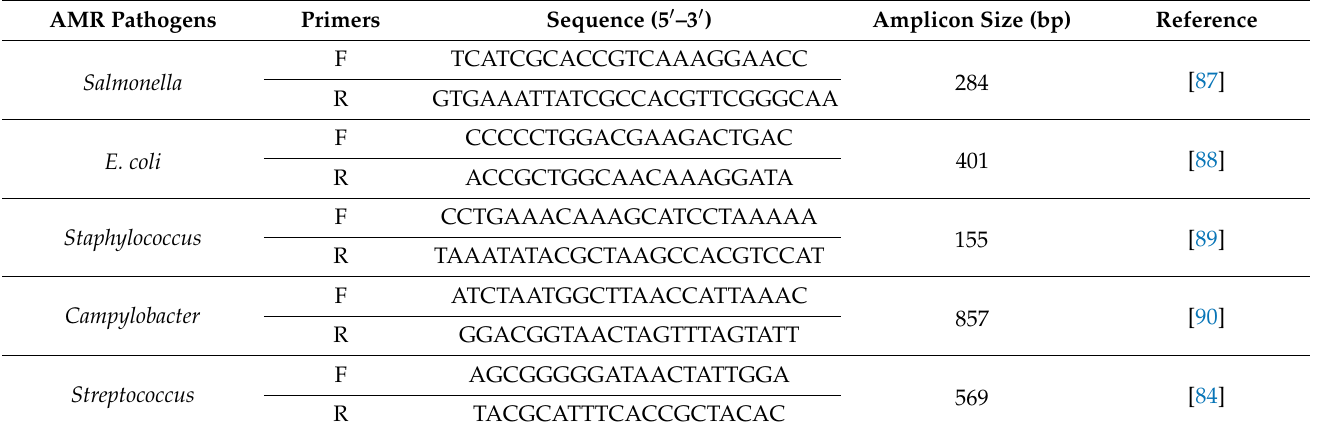
Table 3. List of primers used for bacterial species